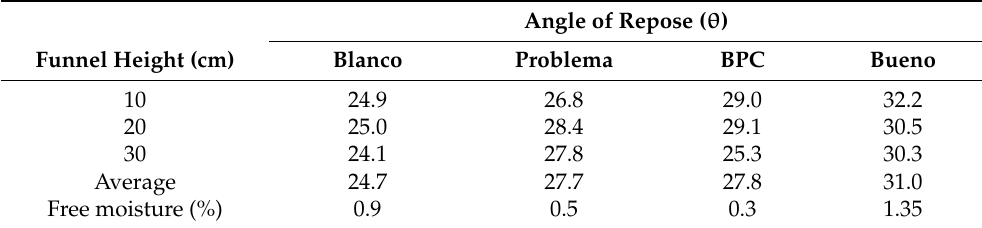
Table 3. Angle of repose ( θ ) and free moisture (%) of KCl mineral sample analyzed. Angle of Repose ( θ ) Funnel Height (cm) Blanco Problema